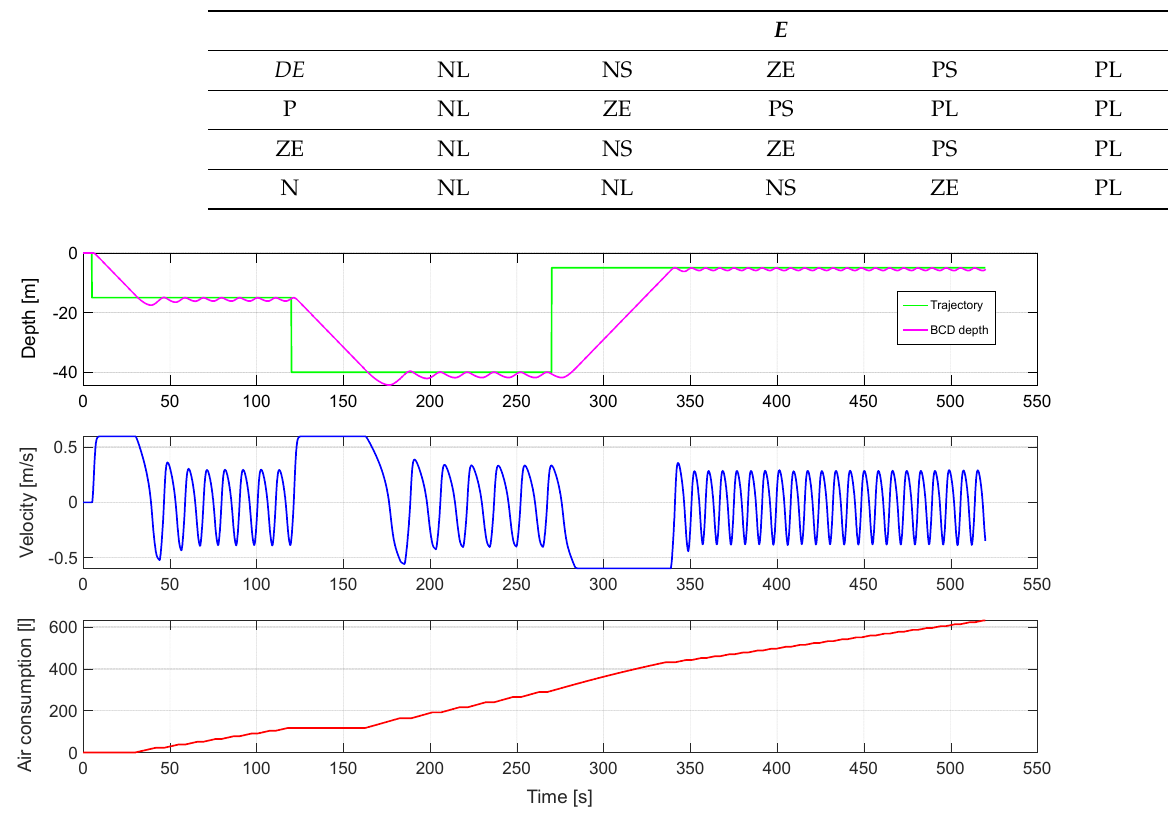
Table 2. Position FLCS parameters used in optimization design. Symbol